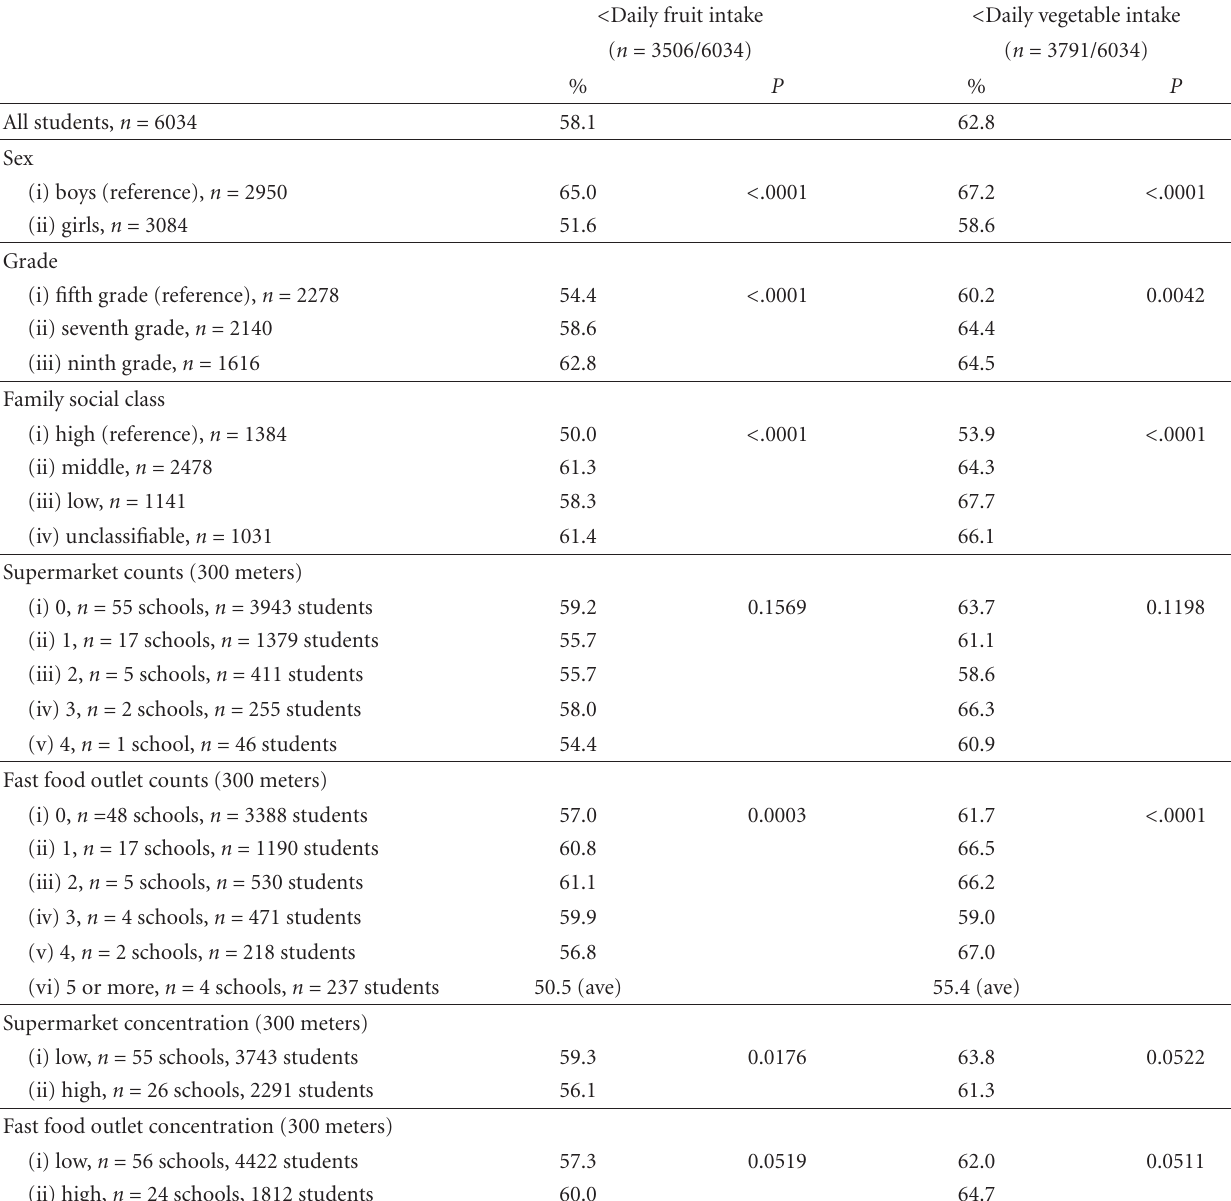
Table 1: Proportion of students with infrequent consumption of fruit or vegetables by sociodemographic characteristics and neighborhood